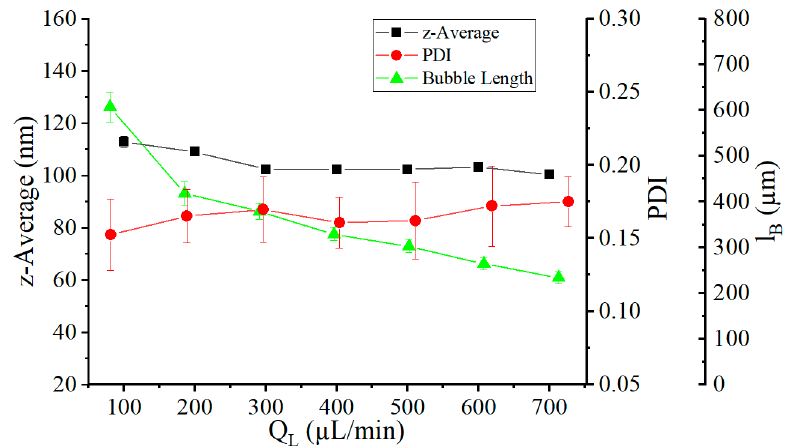
Figure 11. The average size of the nanoparticles and their polydispersity index (PDI) with a fixed plug size of 400 µm and a total liquid flow rate of 100 µL/min to 700 µL/min in the nontempered system. The concentration of the organic phase to the liquid volume flow was 30%.